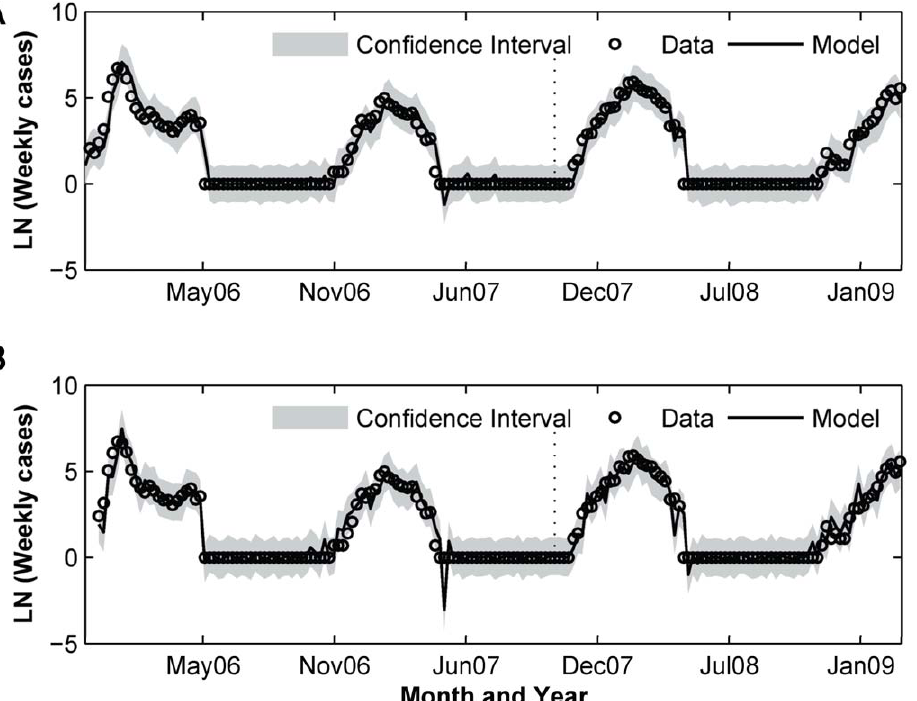
Figure 6. Maricopa County fitted and predicted values–as separated by the dashed line–from (A) SARIMAX with T mean lag 1 and 7, (B) SARIMAX with P max lag 0 and 6.